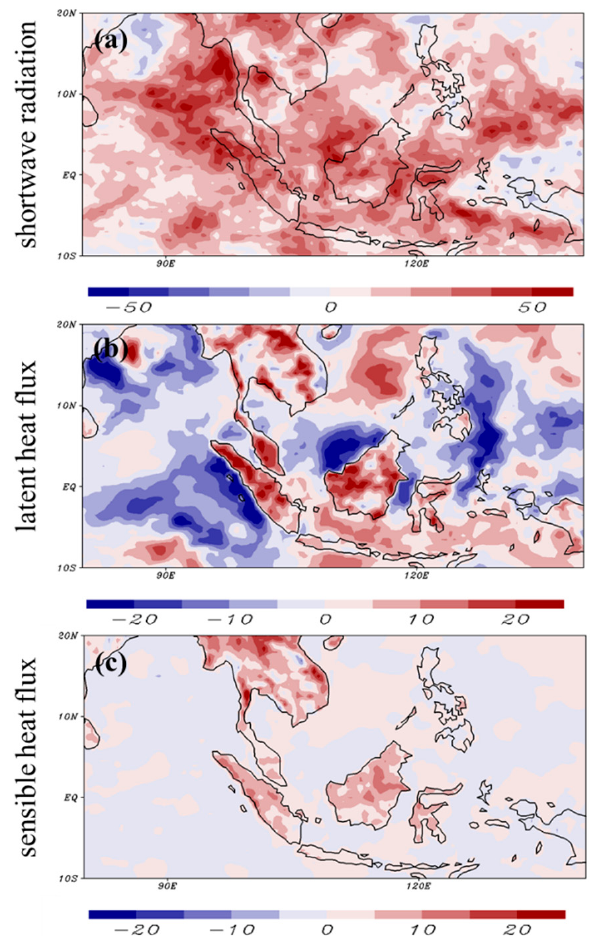
Figure 8. Differences in ( a ) shortwave radiation (w m − 2 ; a positive value indicates downward), ( b ) latent heat flux (w m − 2 ; a positive value indicates upward) and ( c ) sensible heat flux (w m − 2 ; a positive value indicates upward) between EXP and CTRL experiments averaged over 96~120